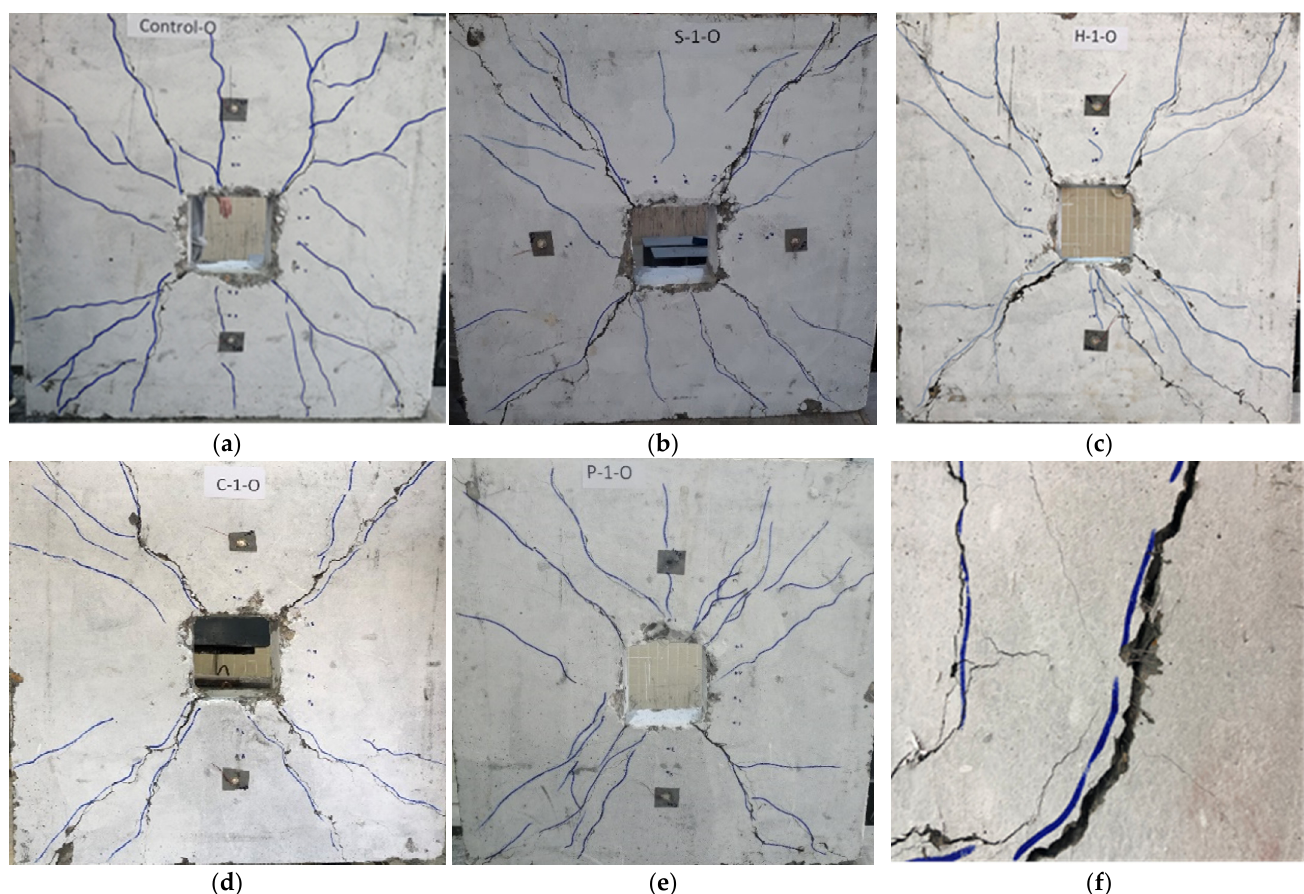
Figure 6. Crack and failure pattern of a slab with an opening. ( a ) Control sample without fiber; ( b ) Slab with straight steel fiber; ( c ) Slab with hooked steel fiber; ( d ) Slab with corrugated steel fiber; ( e ) Slab with polyolefin fiber; ( f ) Fracture failure of slab with